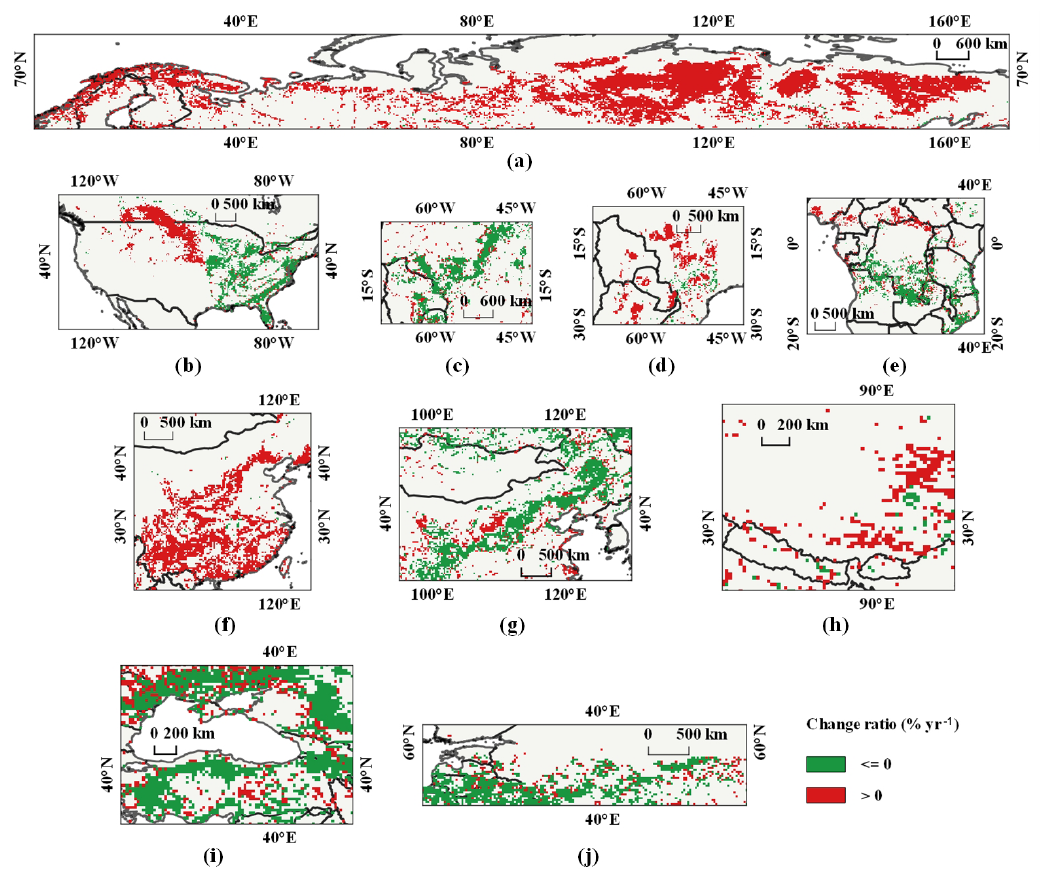
Figure 14. Visualization of local hotspots of land cover change: (a) northern Eurasia, forest; (b) Great Plains of central North America, cropland; (c) South America, forest; (d) South America, cropland; (e) Africa, forest; (f) China, forest; (g) Mongolia and Inner Mongolia (China), grassland; (h) Qinghai–Tibet Plateau, grassland; (i) central Asia, grassland; (j) the former Soviet Union in eastern Europe,